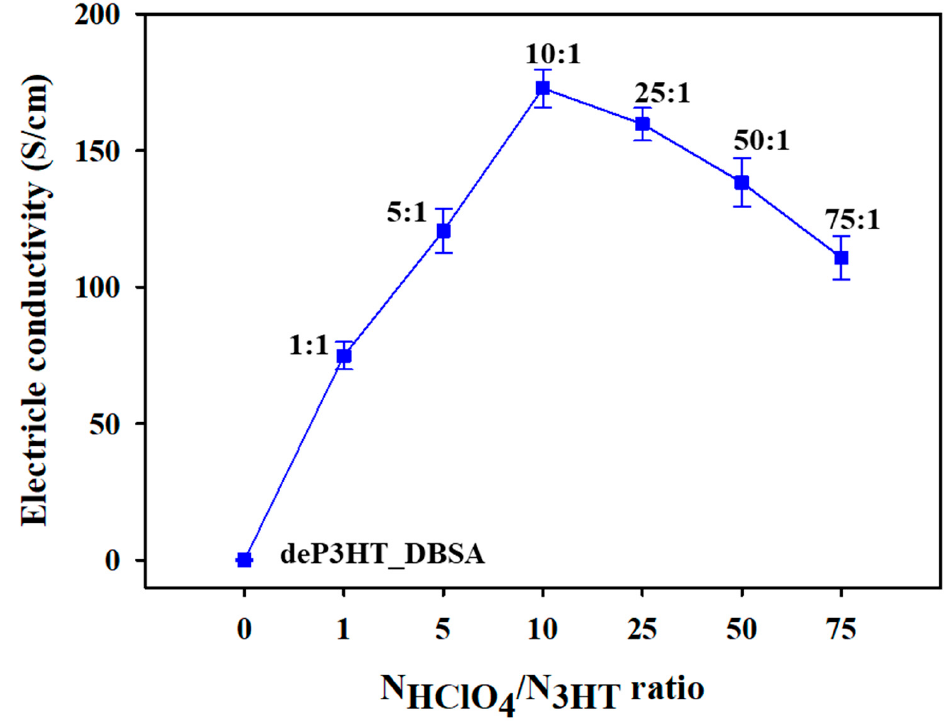
Figure 8. Electrical conductivity of the de-doped P3HT_DBSA and HClO 4 doped P3HT_DBSA at different N HClO /N 3HT doping mole ratios. 4